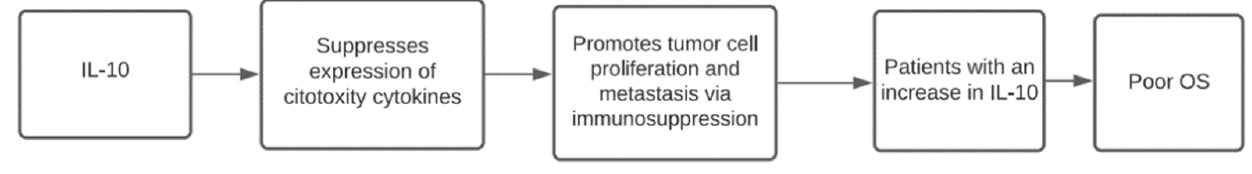
Figure 10. Changes of IL-10 from T0 to T1, its functional meanings, and its effect on the patients’ outcome.